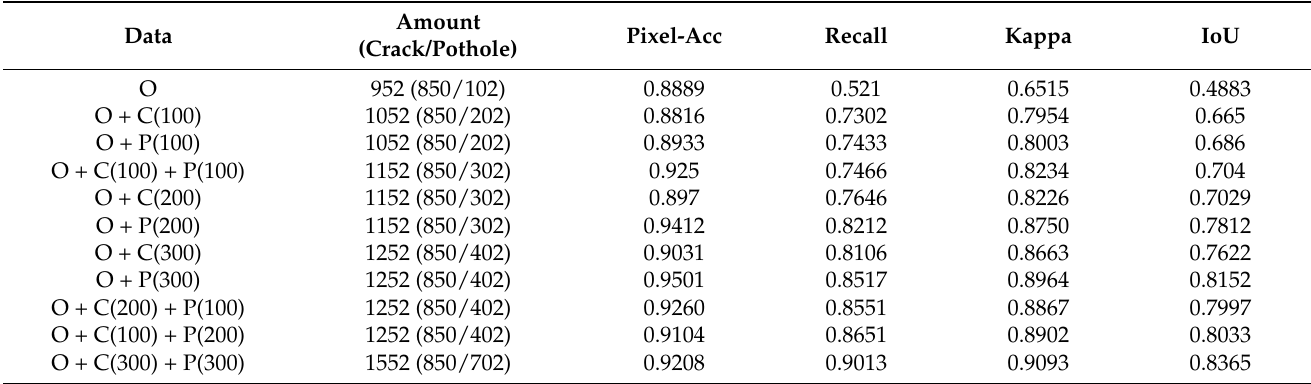
Table 4. Pothole detection results under different training data, original data (O), data augmented by conventional (C), and proposed algorithms